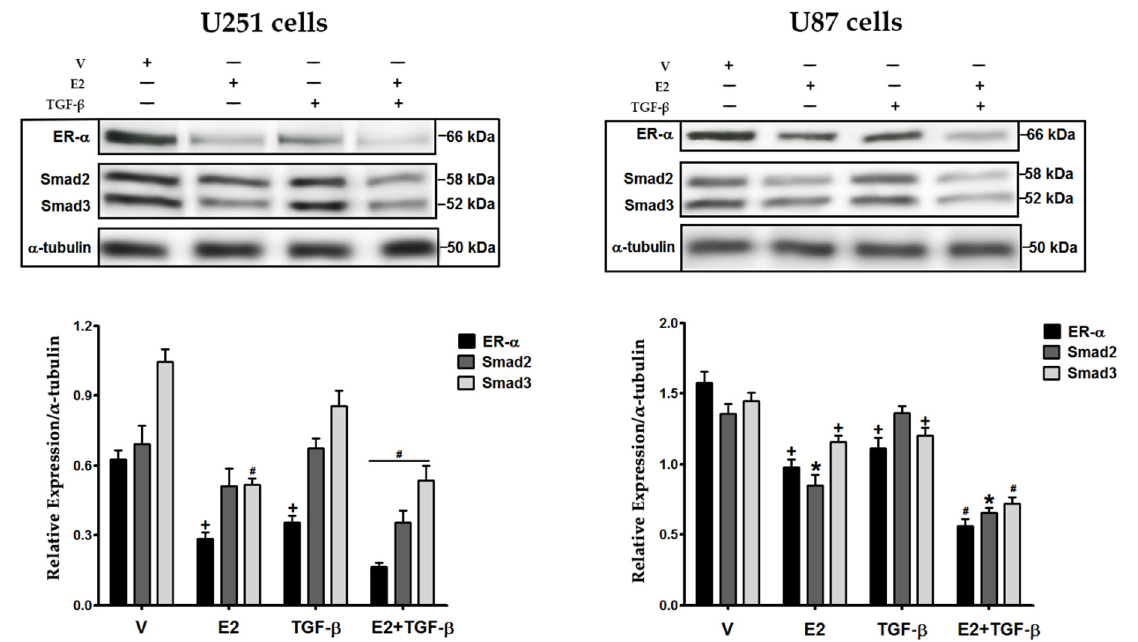
Figure 1. Effects of 17 β estradiol (E2) and transforming growth factor β (TGF −β ) on the expression of estrogen receptor α (ER- α ), Smad2, and Smad3 in human GBM-derived cells. U251 and U87 cells were treated with vehicle (V, 0.01% cyclodextrin + 0.0001% BSA), E2 (10 nM), TGF- β (10 ng/mL) and E2 + TGF- β for 48 h. The expression of ER- α , Smad2, and Smad3 proteins was determined by Western Blot using α -tubulin as load control. Results are expressed as the mean ± standard error of the mean (SEM); n = 3; * p < 0.05 vs. all other groups; # p < 0.05 vs. V and TGF- β ; + p < 0.05 vs. V.